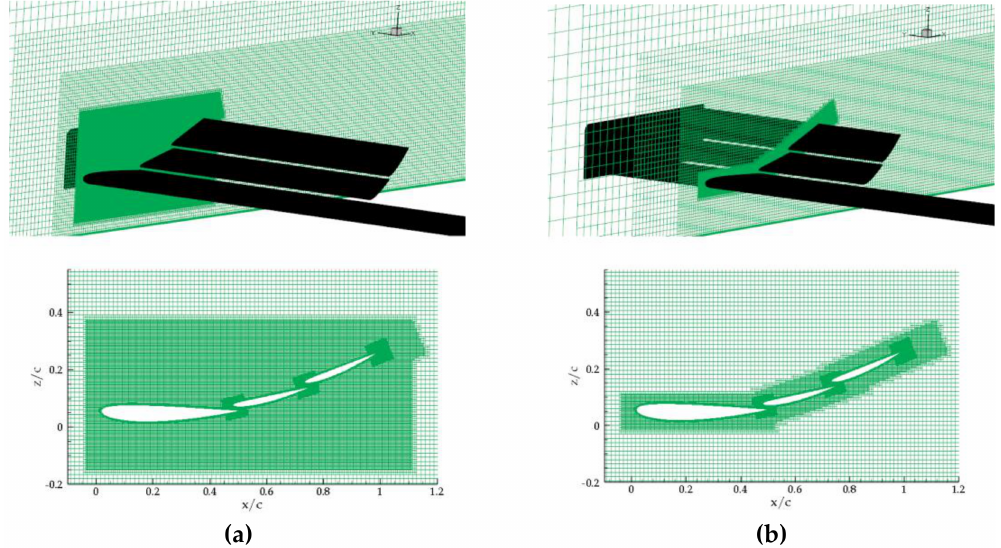
Figure 5. An illustration of the final mesh obtained from the mesh sensitivity study. ( a ) y wi /c = 1.11; ( b ) y wi /c =